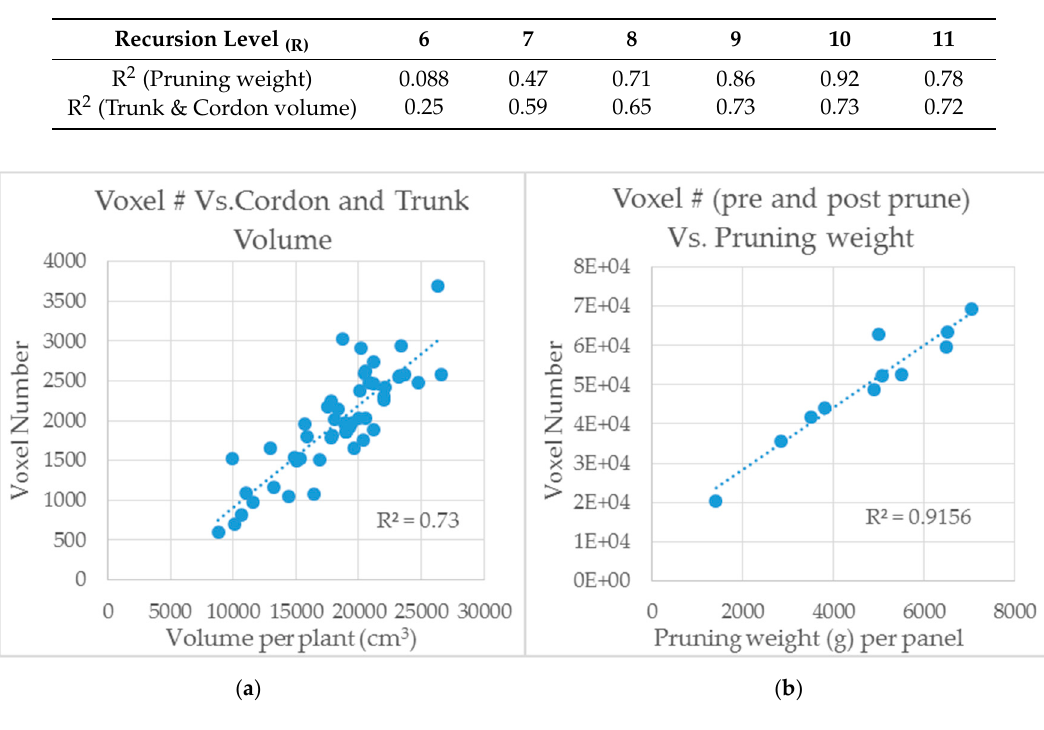
Table 1. This shows the R 2 of the linear correlation between the voxel number, pruning weight and trunk and cordon volume at increasing levels of octree voxelization (recursion level (R) ). Levels of recursion range from 6 to 11. The highest R 2 value for pruning weight was recursion level 10 and for trunk and cordon volume it was recursion levels 9 and 10.